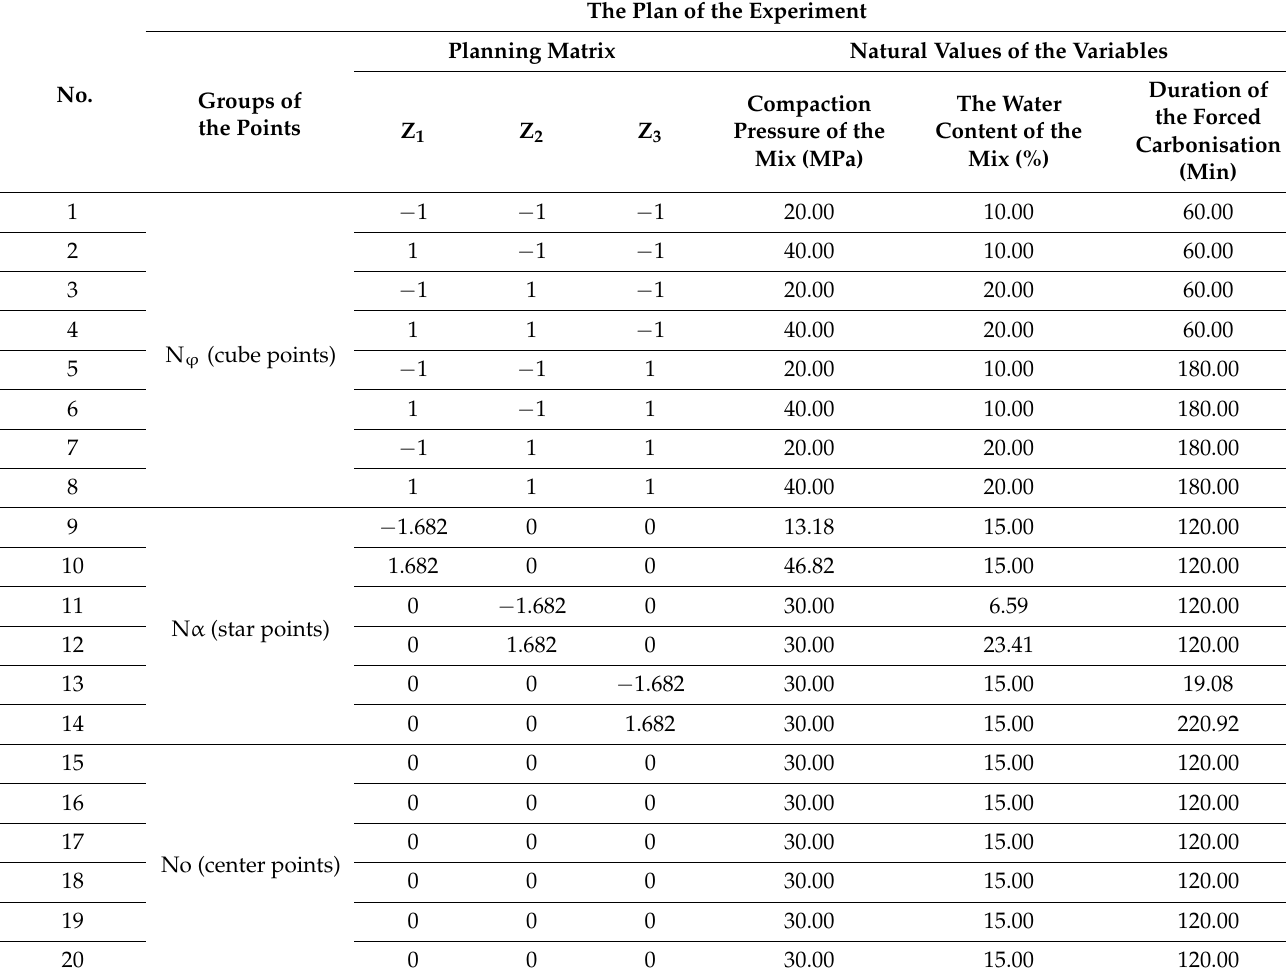
Table 4. The matrix for the planning of the experiment in the encoded and natural expression of the variables.